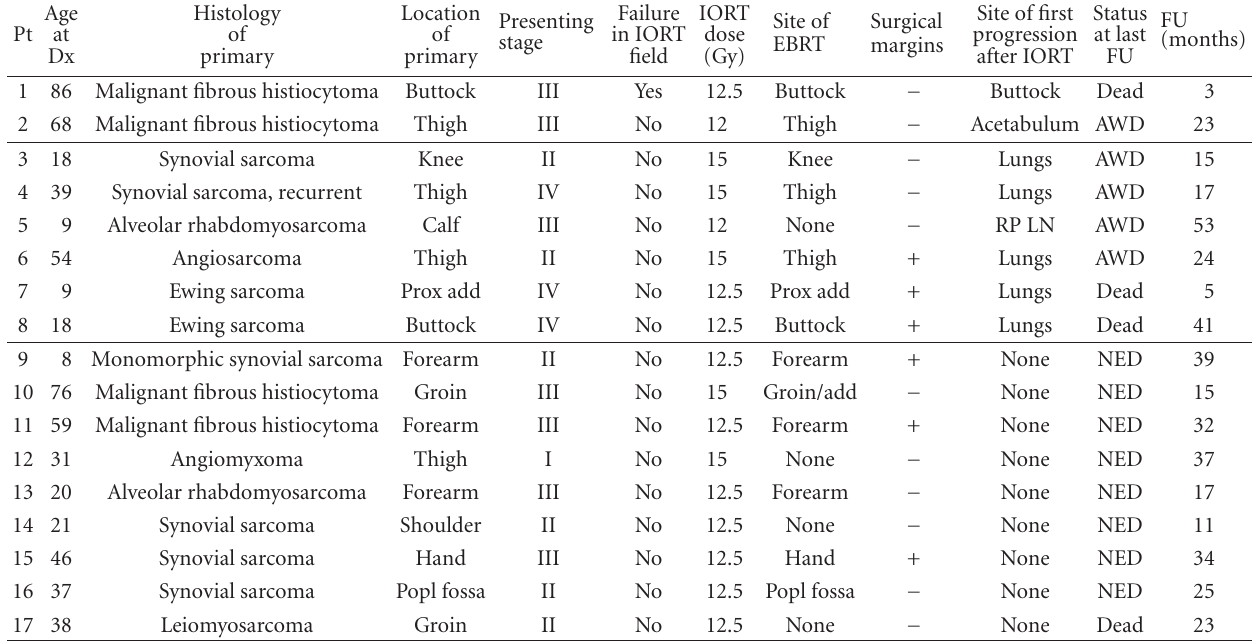
Table 2: Patient outcome and